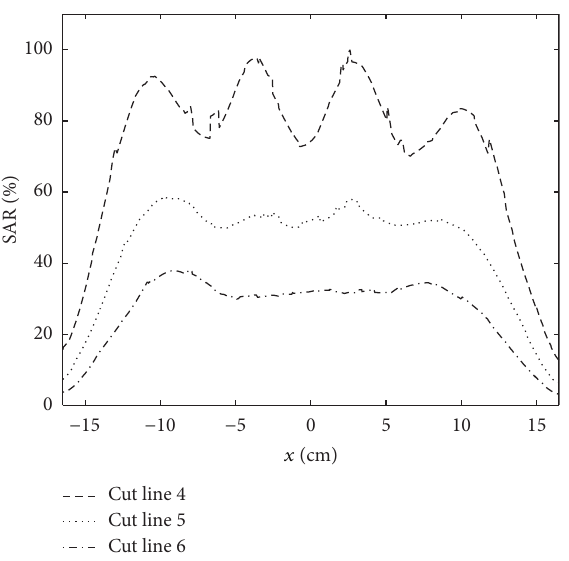
Figure 9: SAR distribution along three line segments (cut lines) which lie in the plane perpendicular to the water bolus/treated area interface. The plane cuts the inductive posts in the middle. The cut lines are parallel to the interface. Cut lines 4, 5, and 6 are located at the interface, at a depth of 1, 2, and 3cm, respectively. SAR values are given as percentages of and are related to the highest SAR value along cut line 4.